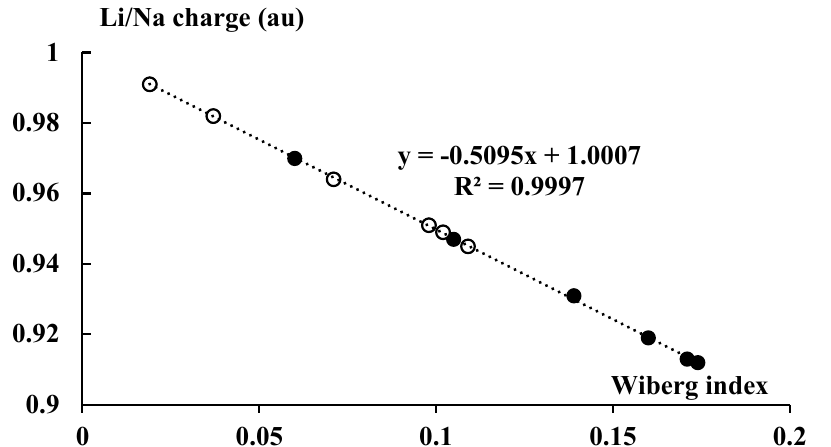
Figure 9. The linear correlation between the total Wiberg index of the Li or Na center and the corresponding NBO charge (in au). The lithium and sodium species are marked by the black and white circles, respectively.